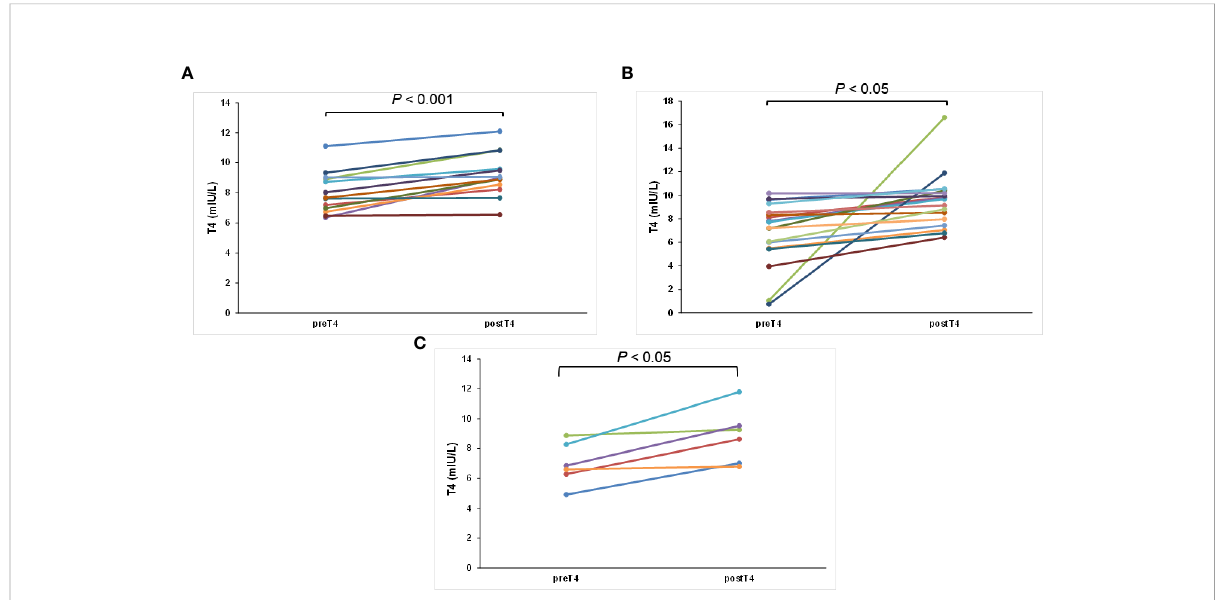
FIGURE 3 The change in T4 concentration for each patient after swallowing the tablet with water and postponing coffee/tea consumption at least 4 h later: (A) only coffee, (B) only tea, and (C) both coffee and tea groups.